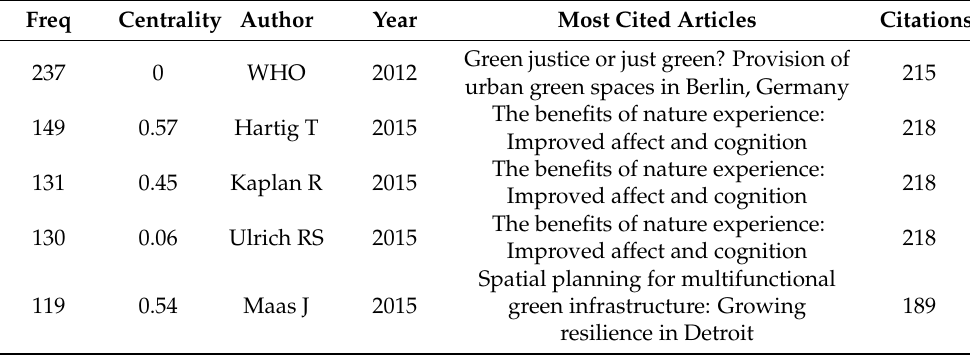
Table 6. Top 5 cited authors and their highly cited articles: 1981–2020.